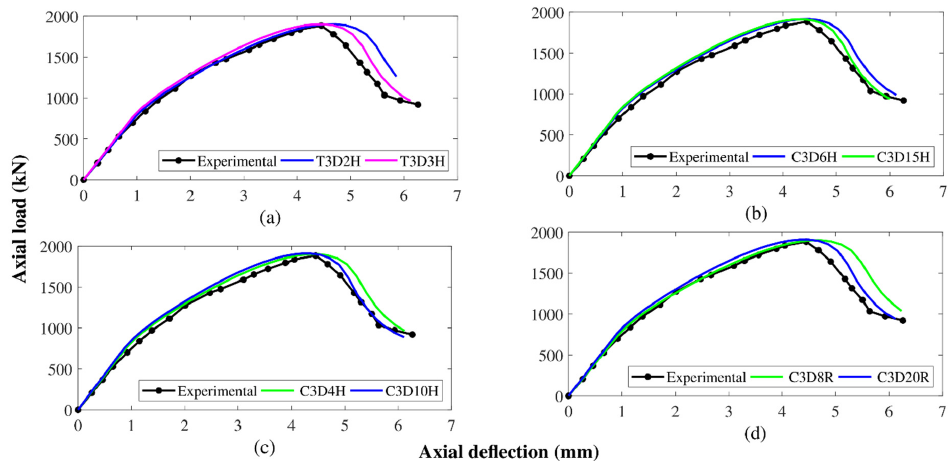
Figure 9. Results of calibration of different types of elements on the behavior of the control sample ( a ) truss types ( b ) triangular types ( c ) tetrahedral types ( d ) hexahedral types.